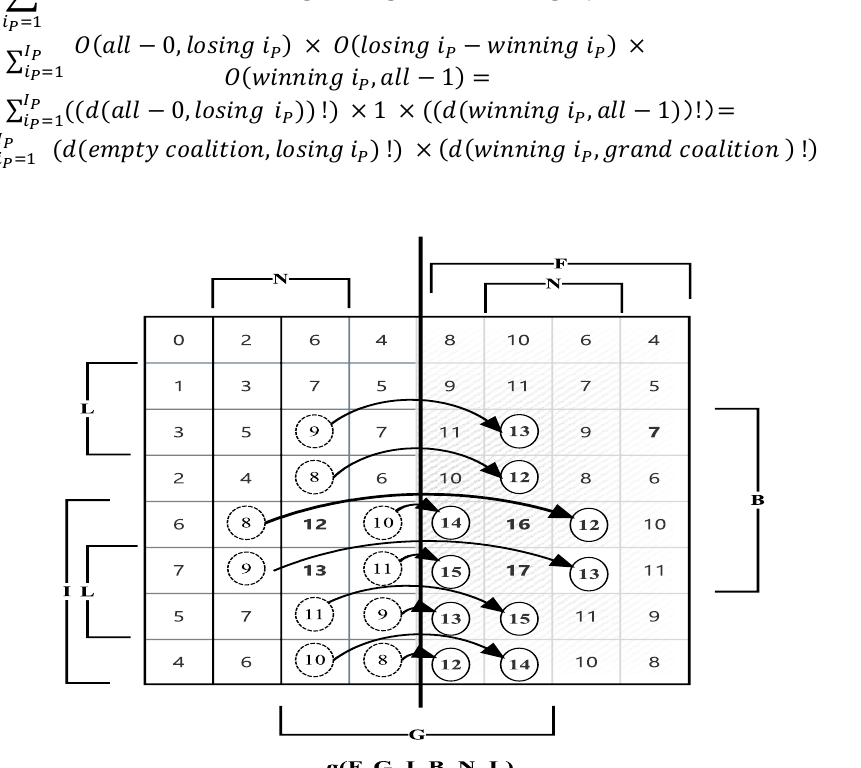
Fig. 5. A pseudo-switching function representing the sum of weighted votes. A pair of critical coalitions w. r. t. F are identified by an arrow going from a critical primitive losing coalition with a non-bold entry within a dotted ellipse to the corresponding critical primitive winning coalition (with bold entry within a continuous